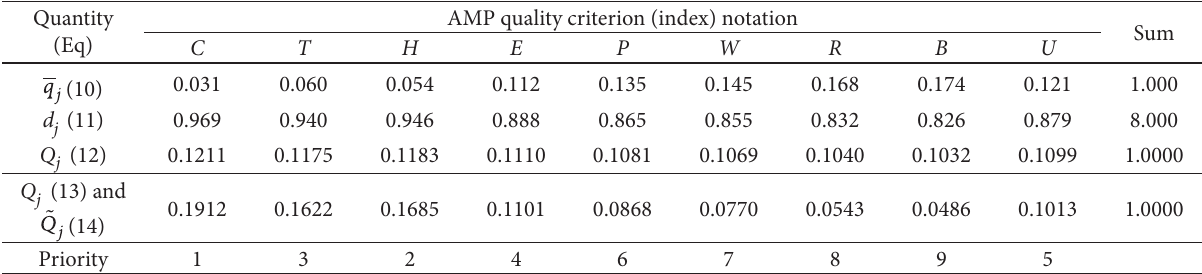
Table 5. The results of AMP quality criteria (indices) significance (weight) and priority calculation, obtained when applying different methodologies Quantity